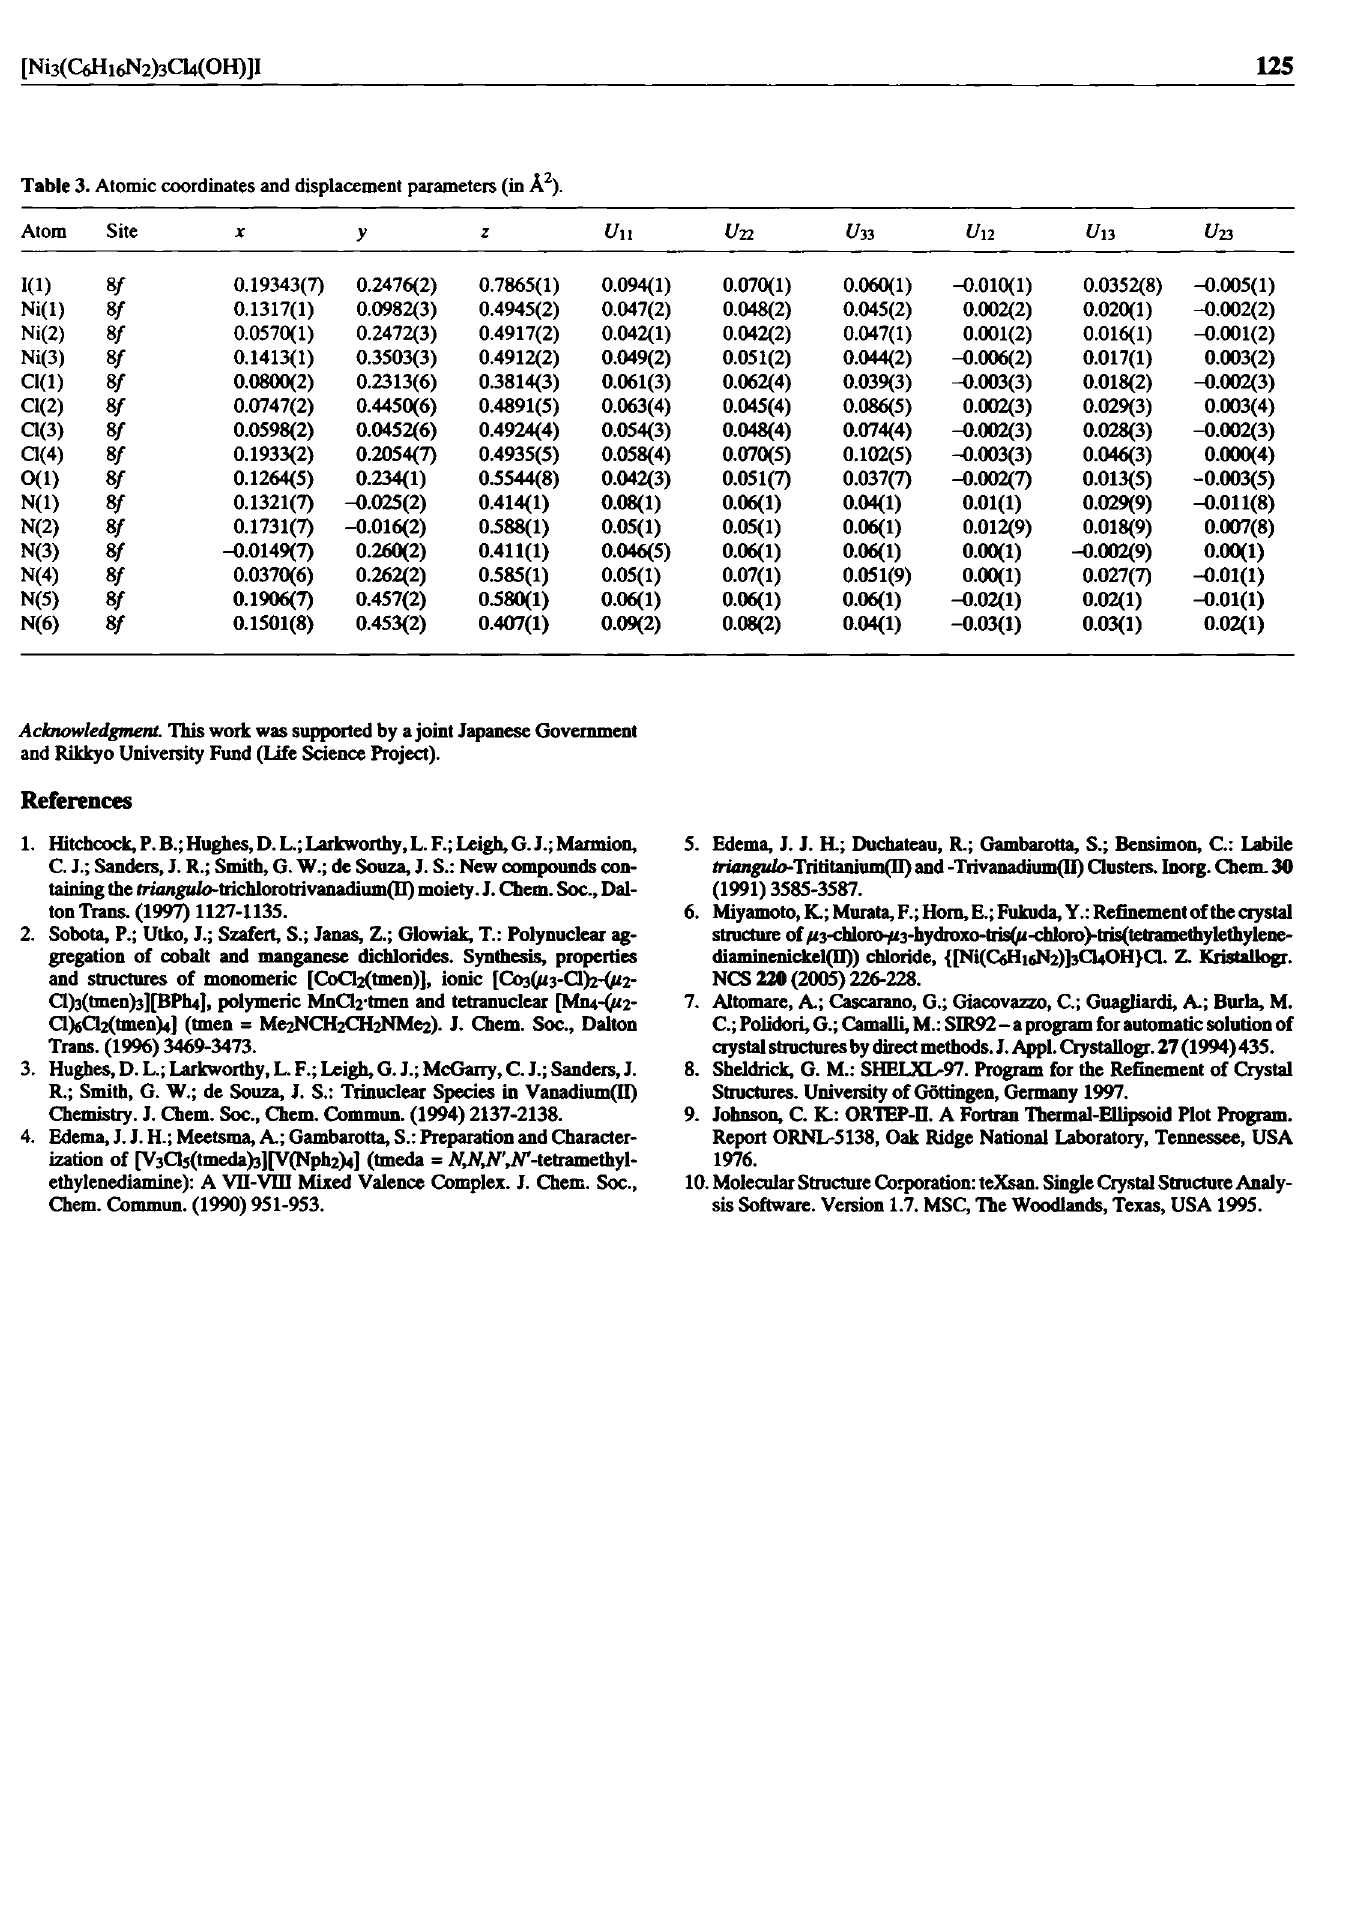
Table 3. Atomic coordinates and displacement parameters (in Ä 2